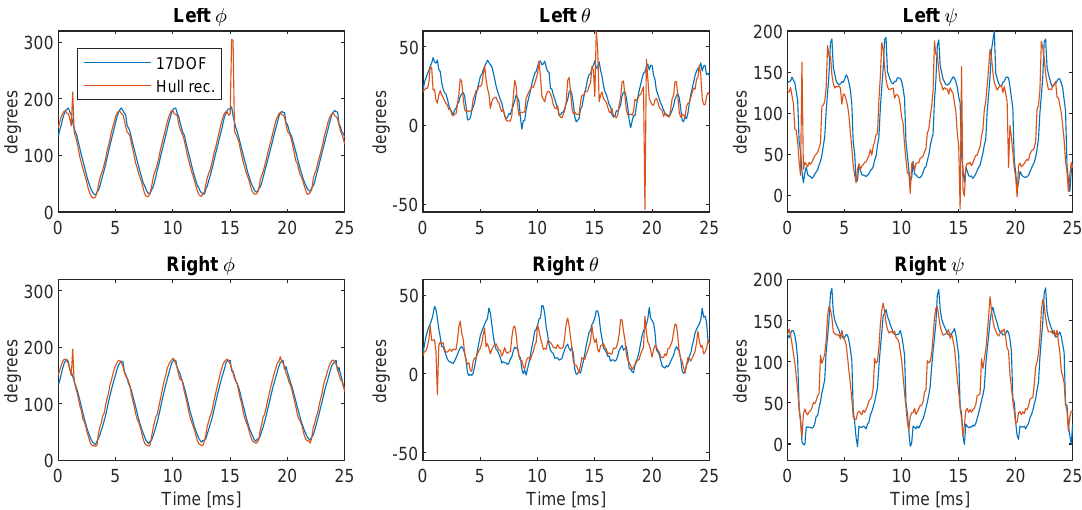
Figure A1. Comparing the 17-DOF model to hull reconstruction tracking in a Cartesian camera configuration. The six plots show 25 ms of wing angles data for both wings, comparing the results of two algorithms: The 17-DOF fitted model reported here (blue) and the hull reconstruction tracking reported in [11,13,14] (red). The video was taken at 8000 frames per second and 512 × 512 pixel resolution.